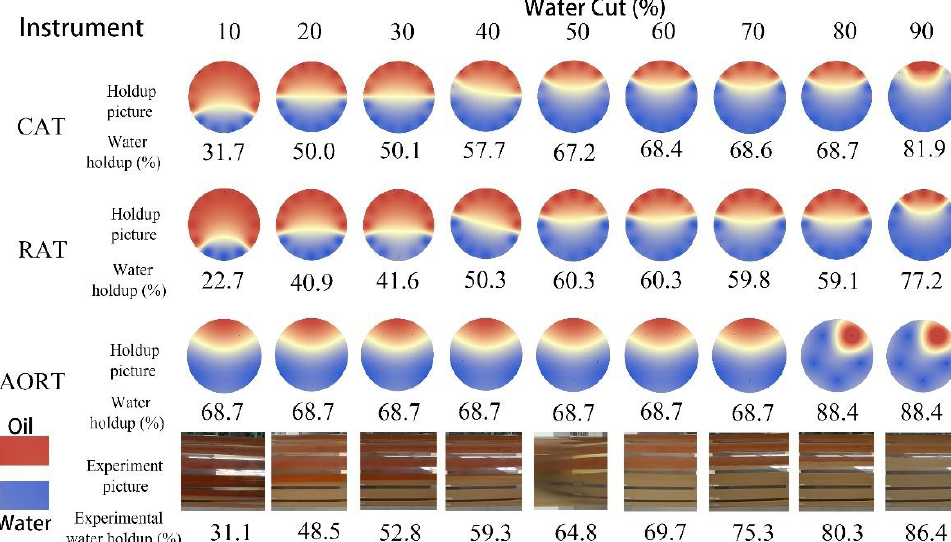
Figure 8. Comparison of interpolation imaging under different water cut conditions of 30 m 3 /d of oil and water. 4. Discussion As shown in Figure 7, according to the experimental photos, it can be found that when the total flowrate of gas and water is 300 m 3 /d, the gas and water are separated. With the increase in the water cut, the height of the liquid level continues to rise, and the water holdup also constantly increases. The image obtained by interpolation of the data measured by CAT, RAT and AORT was compared with the experimental photos. In the case of separation of gas and water, the measured data of CAT and RAT can reflect the phenomenon that, as the water cut increases, the water holdup increases. The effect of RAT is better, which is closer to the experimental gas – water interface and water holdup; although AORT leads to a change in water holdup, the effect is slightly worse. However, the analysis showed that it is possible to use a combination of AORT and RAT instruments